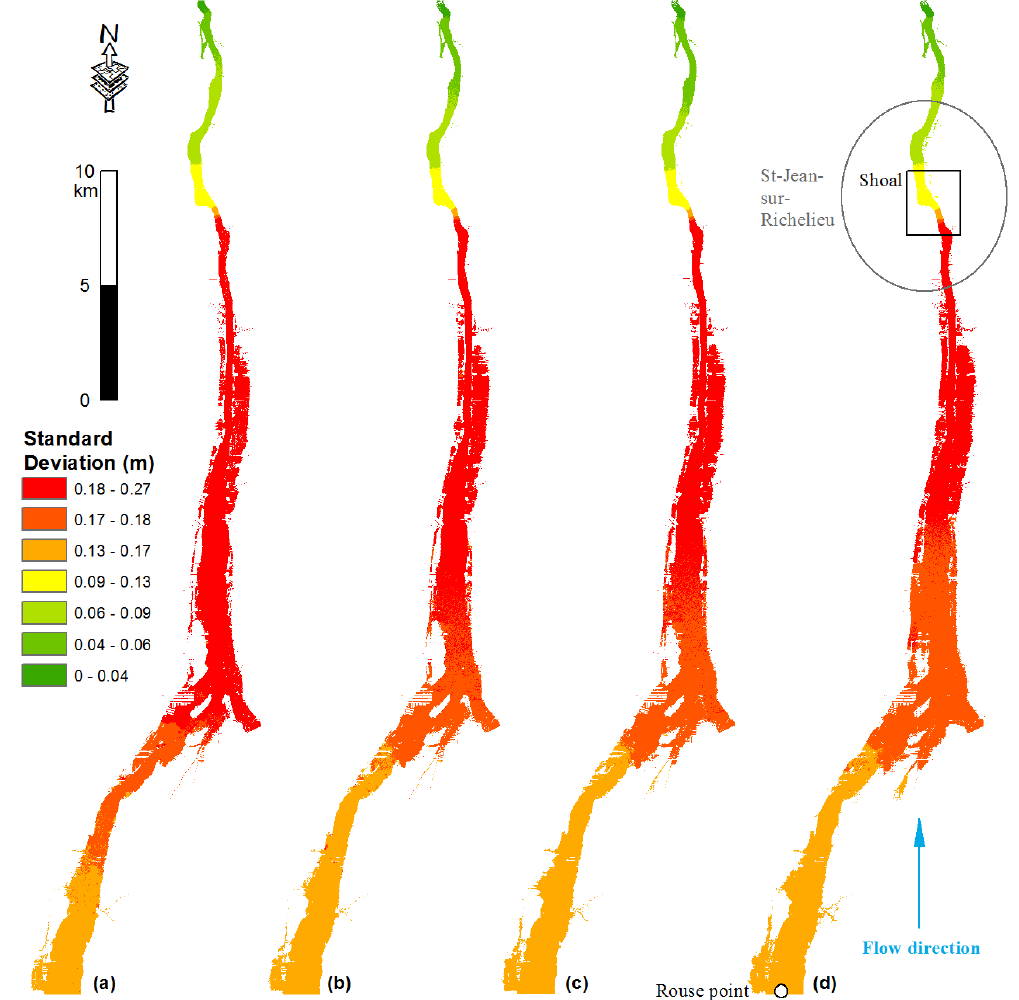
Figure 8 . Standard deviations of water depth predicted with the point estimate method for four flow rates: ( a ) 759 m 3 /s ; ( b ) 824 m 3 /s ; ( c ) 936 m 3 /s ; and ( d ) 1113 m 3